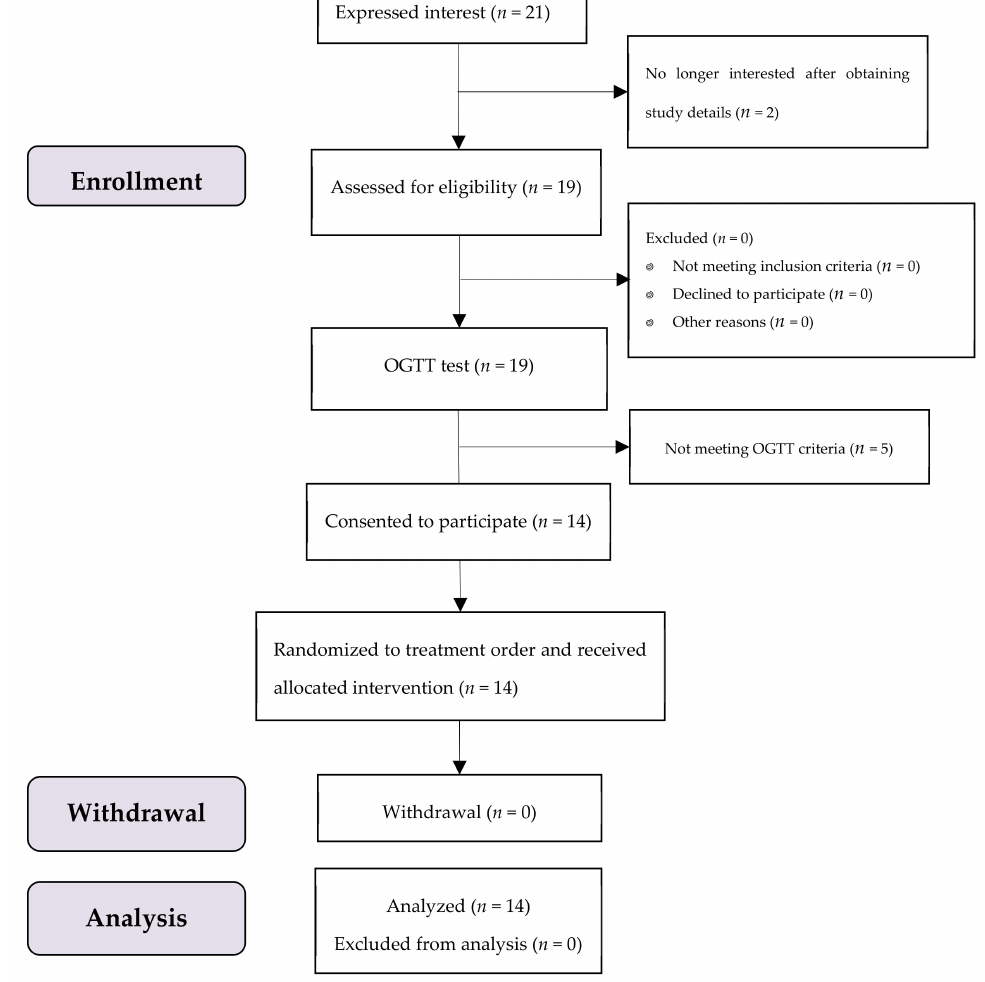
Figure 2. The study subjects flow